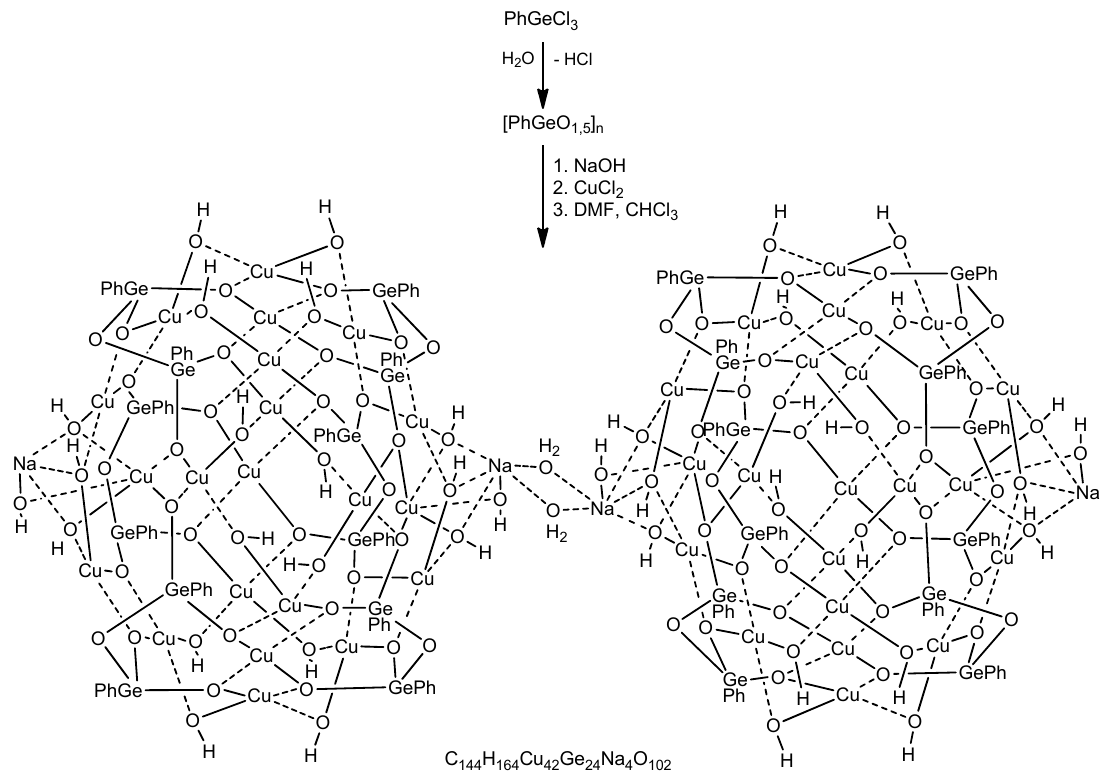
Figure 1. General scheme of synthesis and structure of coppersodiumgermsesquioxane 1 .